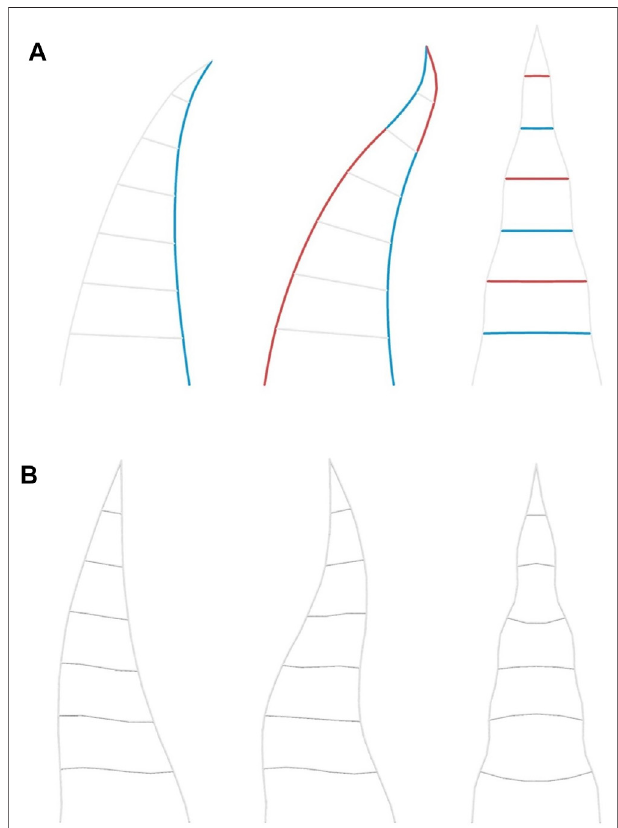
FIGURE 11 | (A) Results of operator χ for curvature of right outer chord for target criteria: f w , I = κ for placement of q = 7 actuators on right chord (left); f w , I (cid:1) | κ | for placement of q = 14 actuators on both outer chords (center); and f w , I (cid:1) | κ | for placement of q = 6 actuators on whole structure (right). (B) Comparative eigenforms: fi rst eigenform (left); second eigenform (center); seventh eigenform